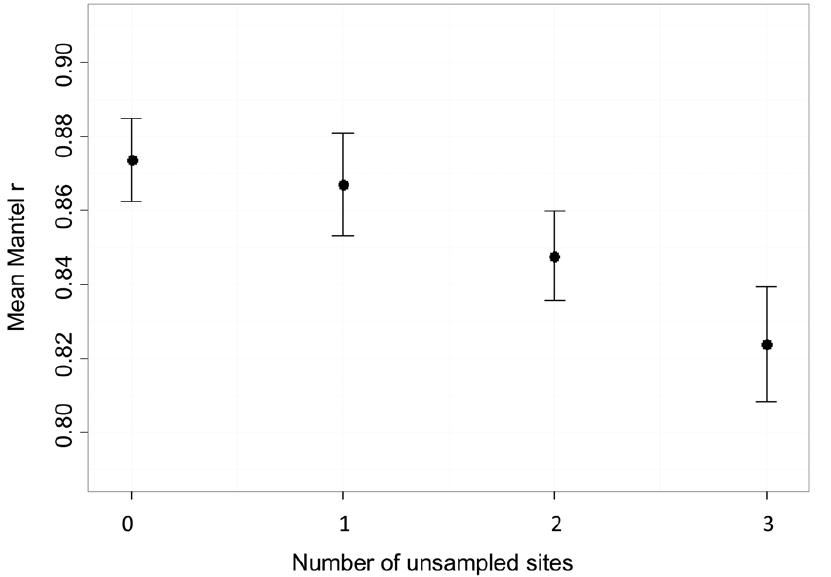
Figure 9. Mean (SE) Mantel r values across 21 replicates of simulated isolation by resistance. Mantel r values are based on conditional genetic distance ( cGD ) and the cost distance (log-transformed) between 6 pairs of sites. We calculated Mantel r values based on four estimates of cGD : when all nine sites were included in the network (0 unsampled populations), when 1 site (site 5) was not included in the network, when 2 sites (sites 4 and 5) were not included in the network, and when 3 sites (sites 4, 5, and 6) were not included in the network. We included only the 6 core sites (sites 1, 2, 3, 7, 8, and 9; see Figure 2) in all calculations of Mantel r .